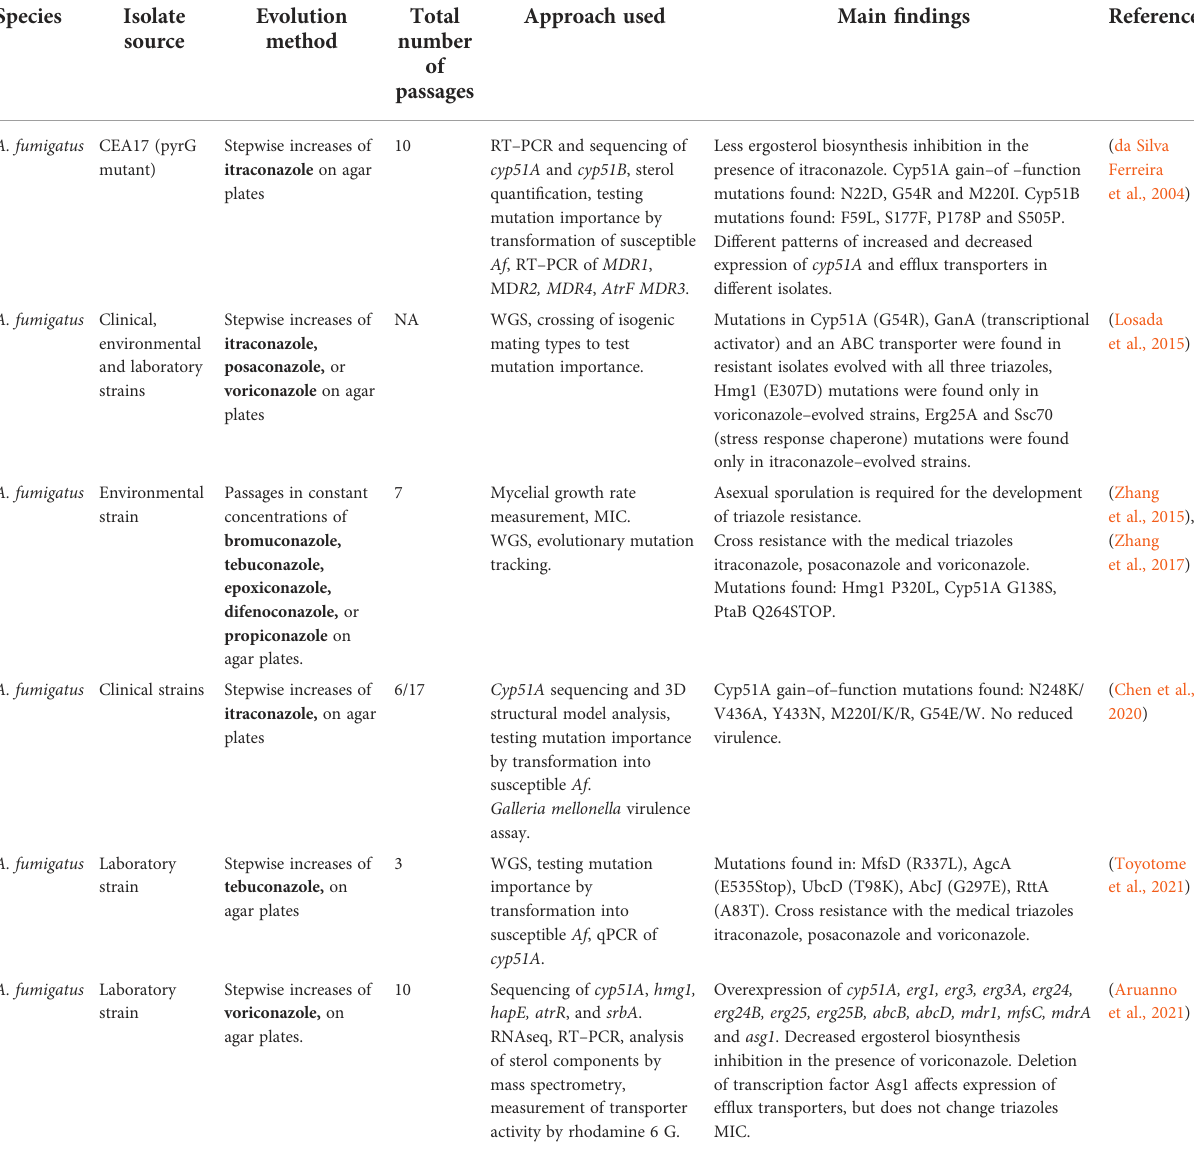
TABLE 7 Development of triazole resistance in A. fumigatus isolates undergoing in – vitro evolution. Species Isolate